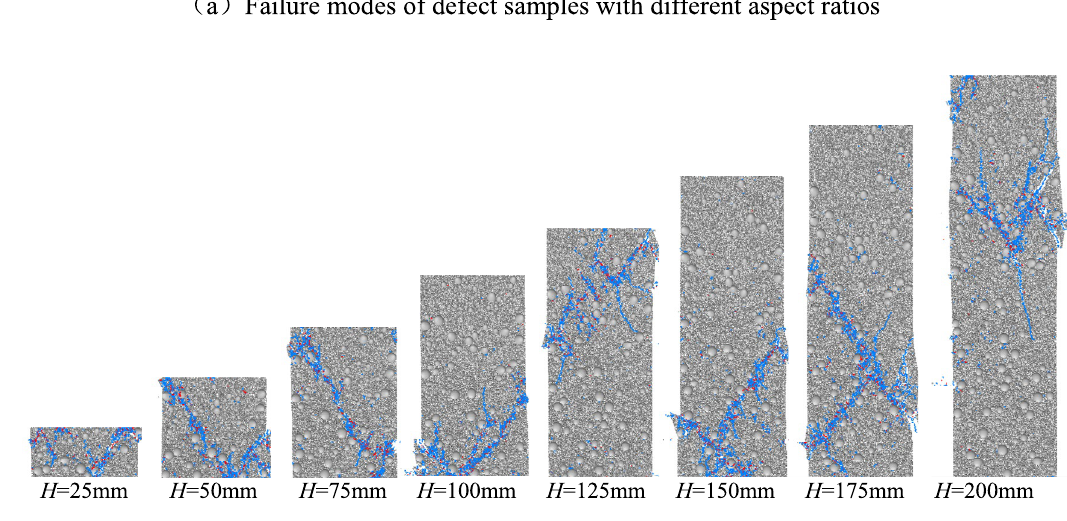
Figure 11. Failure modes of specimens with different aspect